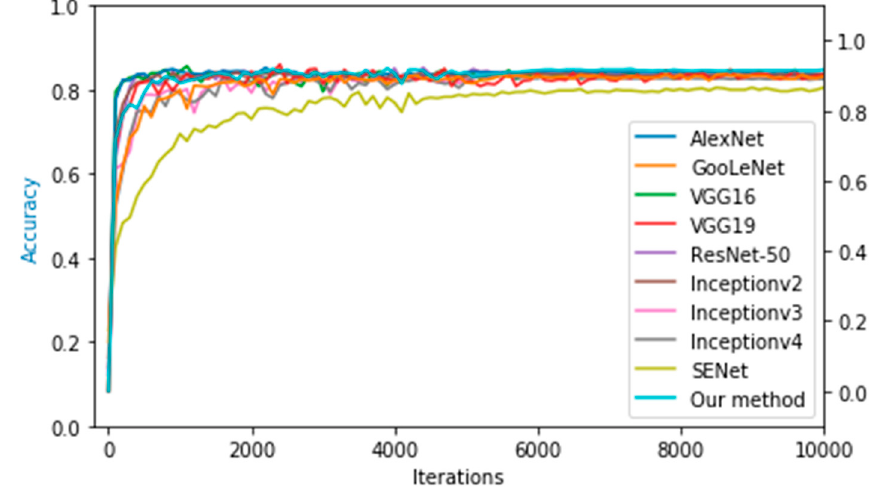
Figure 7. Trends in the accuracy of different CNN models on the test set.